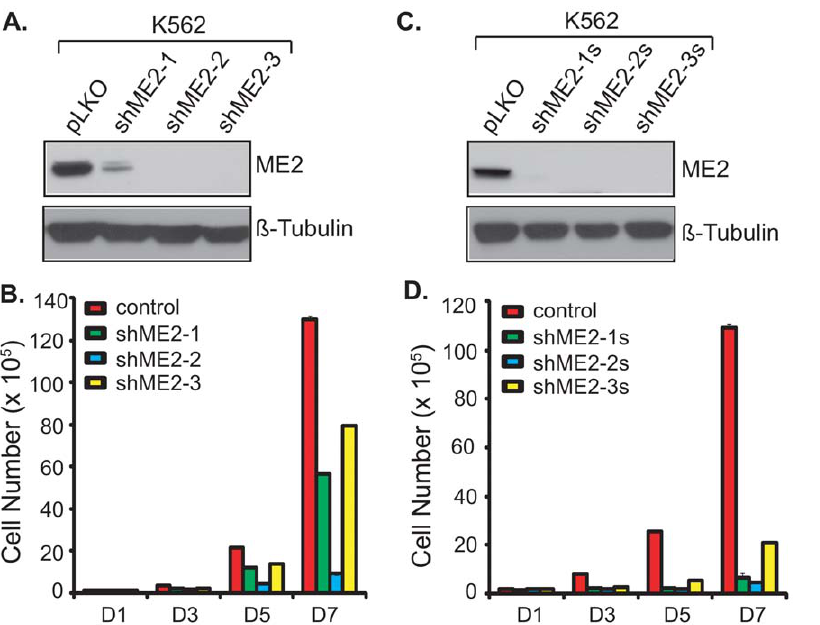
Figure 1. Effects on K562 cell proliferation of three independent shRNA hairpins targeting ME2. A: Western blot analysis using an ME2 antibody of lysate from respective pools of cells transduced with three independent ME2 shRNA lentiviruses, and following selection of puromycin for 10 days as described under ‘‘Materials and Methods’’. Data are representative of two independent experiments. All three pools showed marked ME2 silencing. B: Cell proliferation in K562 cells transduced with the indicated shRNA lentiviral constructs as described in ‘‘A’’. Data are representative of three independent experiments. C: Western blot analysis of cellular extracts in single clone K562 cells as described under ‘‘Materials and Methods’’ demonstrated effective knockdown of ME2 levels. Data are representative of two independent experiments. D: Cell proliferation of K562 single cell clones with ME2 knockdown derived from the corresponding pools as described in ‘‘C’’. Data are representative of three independent experiments.